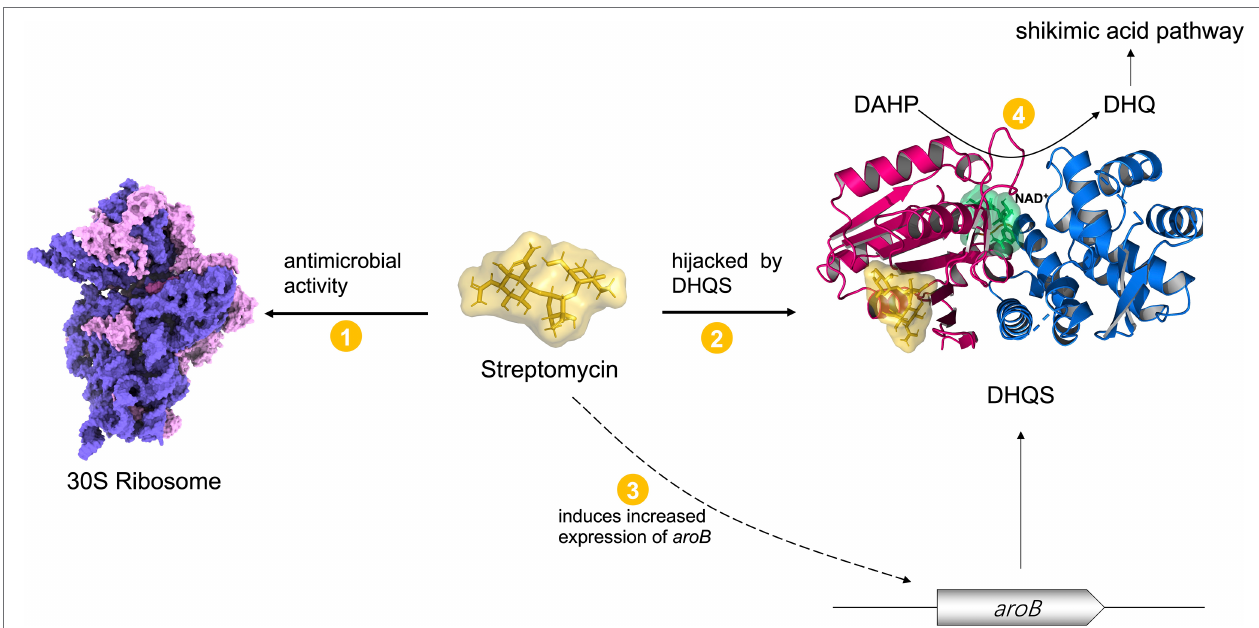
FIGURE 6 | A model in which DHQS mediates streptomycin susceptibility. Streptomycin inhibits bacteria by targeting 30S ribosome. The expression of DHQS protein was increased under streptomycin treatment. DHQS directly bound to streptomycin while retaining its own normal catalytic activity. As a result, DHQS “hijacks” streptomycin, thus reducing the binding of streptomycin to 30S ribosome target, eventually reducing the susceptibility of bacteria to